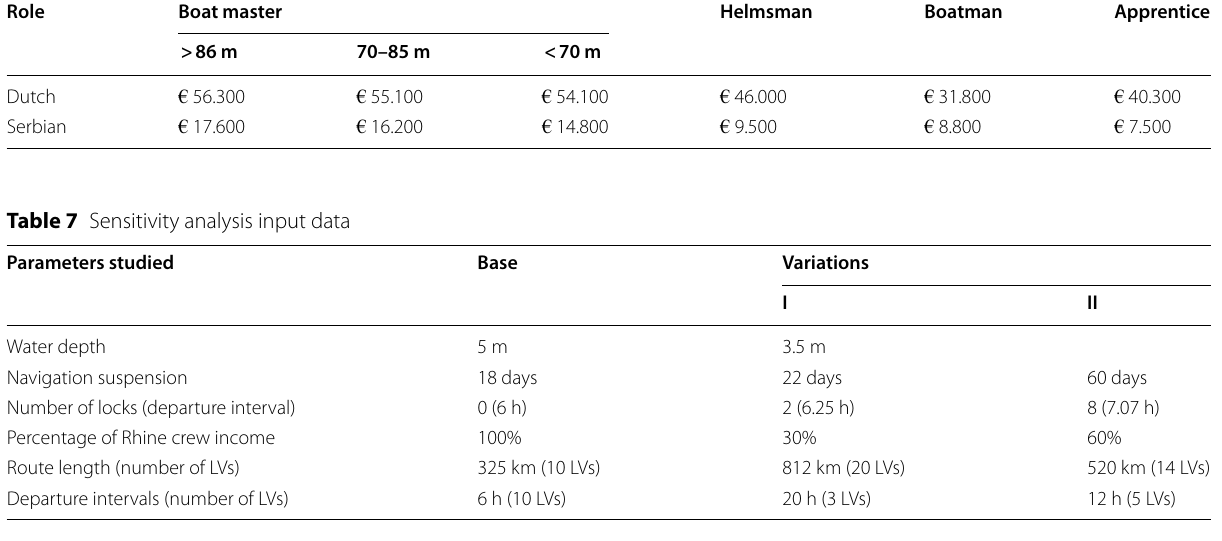
Table 6 Annual wage of inland crew per role Role